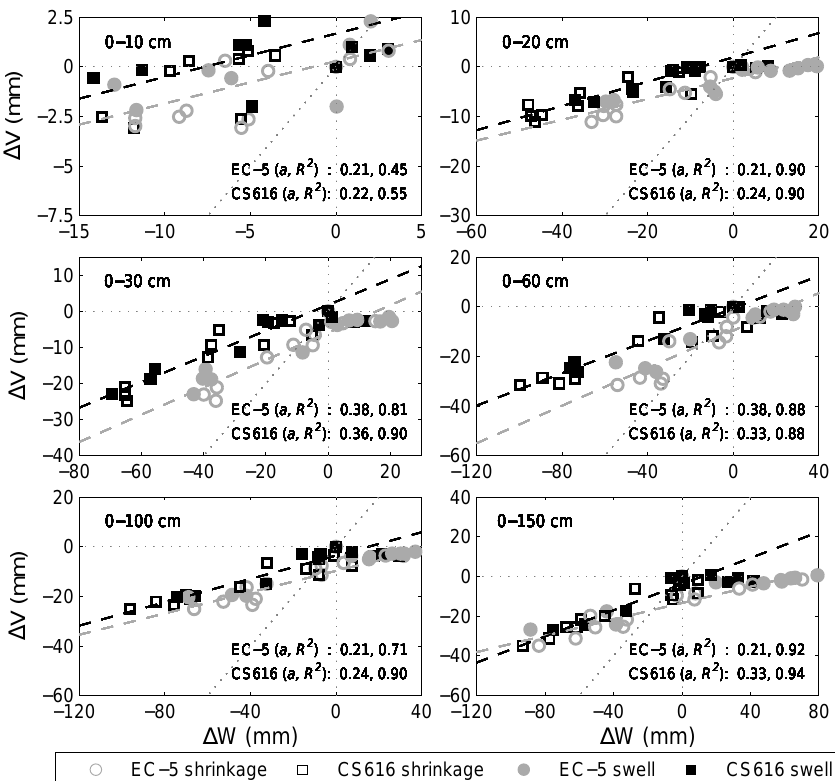
Fig. 10. Relationship between volume change per unit area 1V and water storage change 1W (EC-5 and CS616) at field B in 2010, for six soil layers. Dashed lines represent linear regression fits through data points outside the structural shrinkage phase, with a indicating the slope of the fit and R 2 being the goodness of fit. Note the difference between the x- and y-axes.